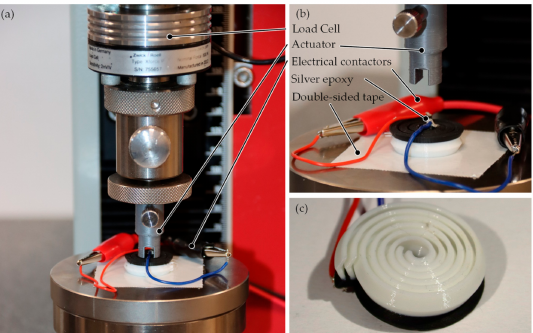
Figure 2. ( a ) Overview picture of the test set-up prior to measurement. ( b ) Close-up of the measure- ment set-up. ( c ) Detail image of substructure variant